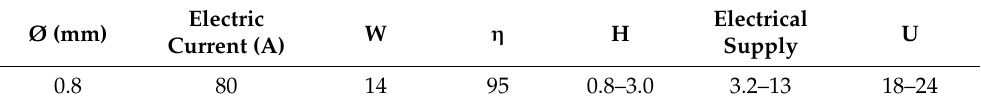
Table 4. ESAB recommended parameters for the AWS 5.18 ER 70S-6